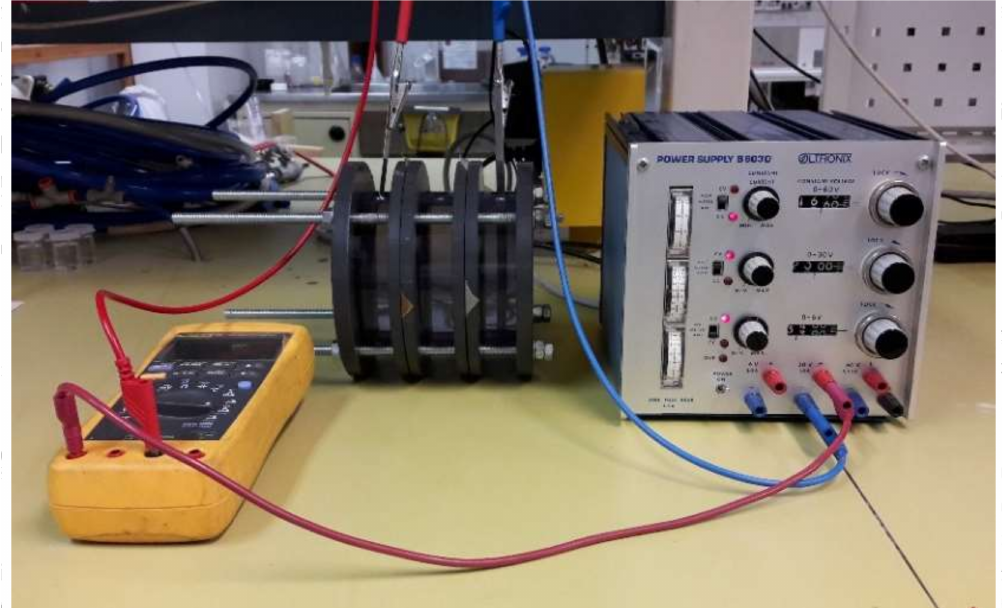
Figure 3. Experimental setup for three compartments showing the power supply (right), electrodialysis stack (middle) and the multimeter for measuring the electric current through the stack